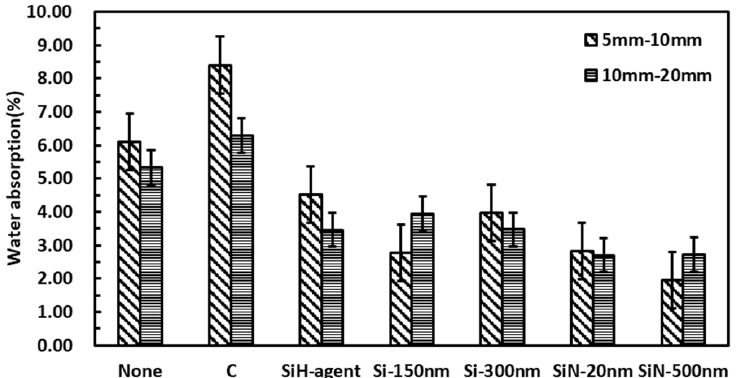
Figure 5. The 24 h water absorption of recycled coarse aggregate modified by different materials.